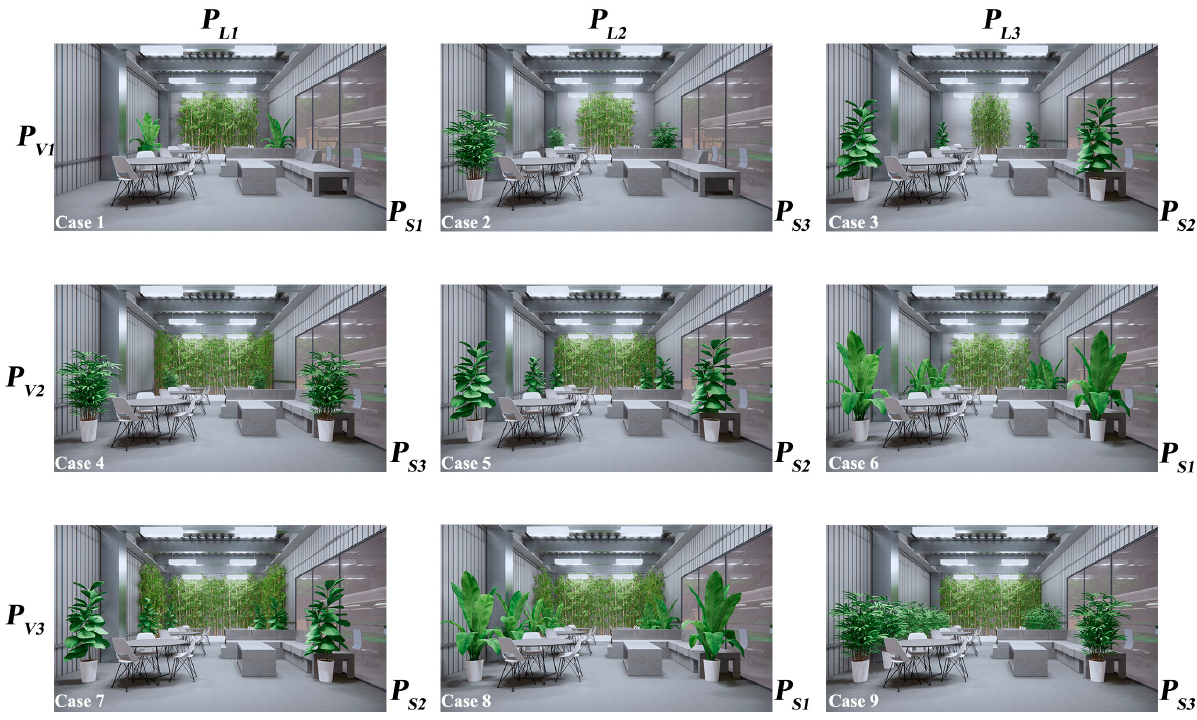
Figure 3. The design of the nine studies cases.